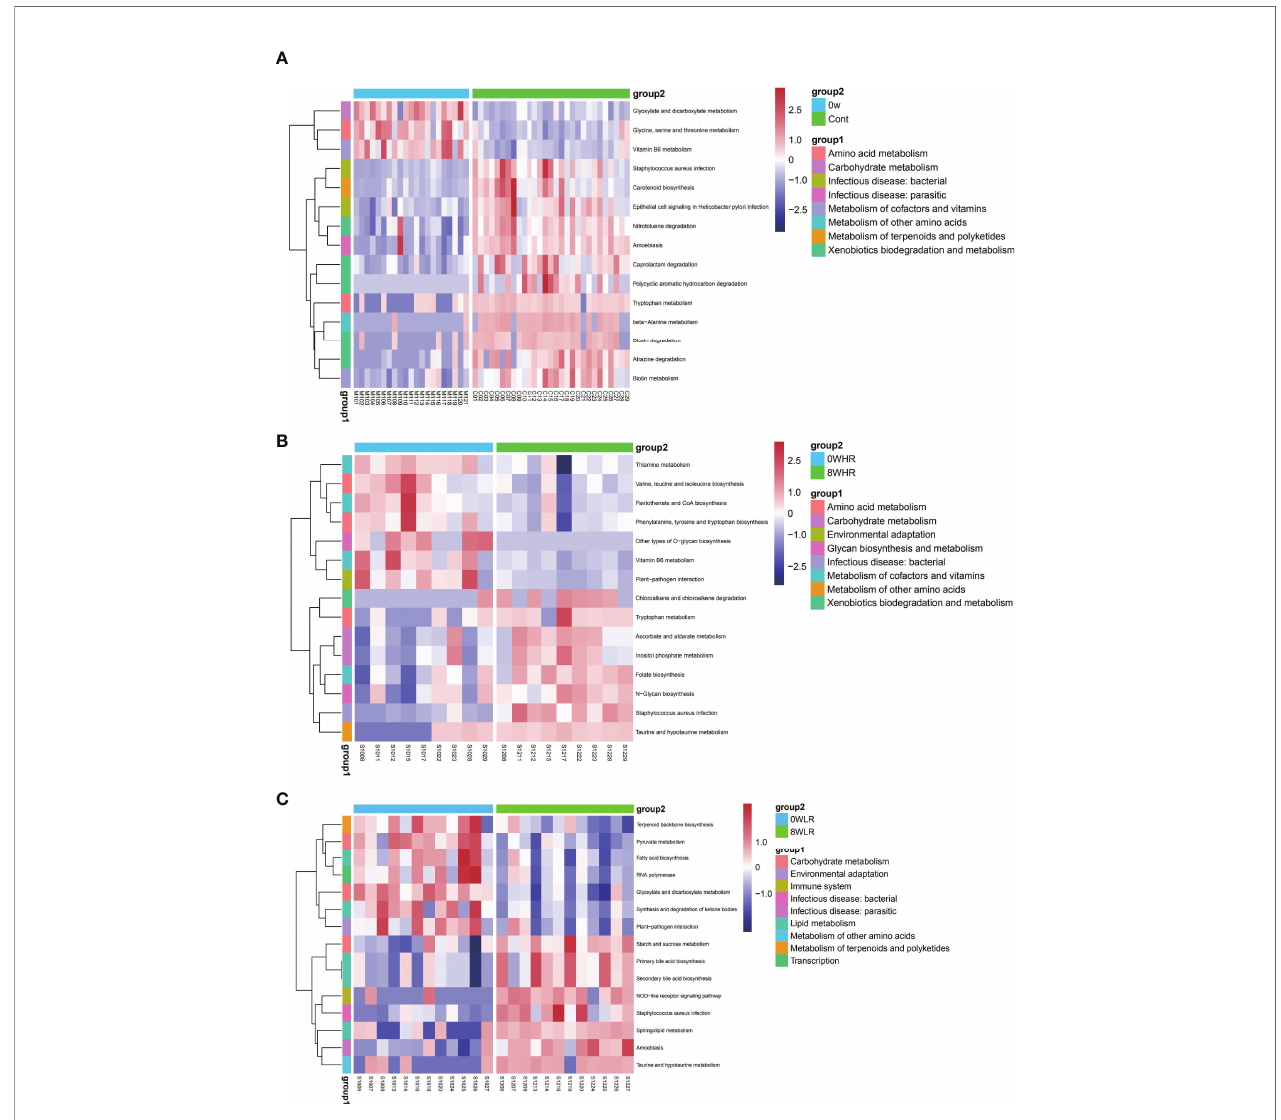
FIGURE 6 | Heat maps of selected signi fi cant metabolites between the high trait anxiety group and healthy control group (A) , before and after intervention among high responders (B) and among low responders (C)